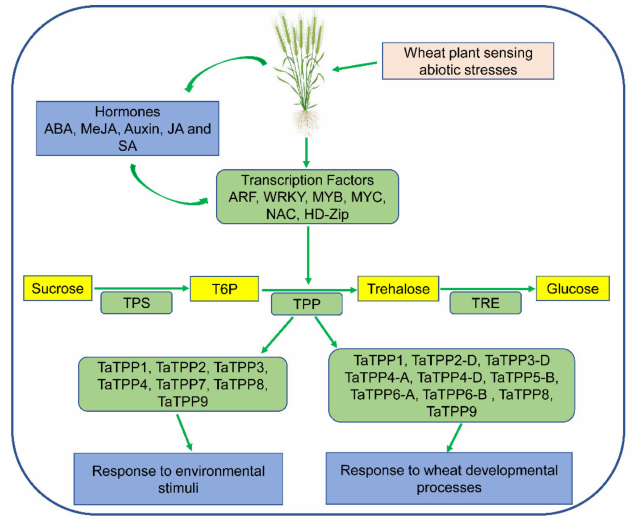
Figure 11. A proposed model for TaTPP genes functions in various wheat developmental processes and diverse stress conditions. ABA: Abscisic acid; MeJA: Methyl jasmonate; JA: Jasmonic acid; SA: Salicylic acid; ARF: Auxin response factors; MYB: Myeloblastosis; NAC: No apical meristem; TPS: trehalose-6-phosphate synthase; T6P: trehalose-6-phosphate; TPP: trehalose-6-phosphate phos- phatase; TRE: trehalase. Yellow boxes indicate carbohydrates and light green boxes indicate